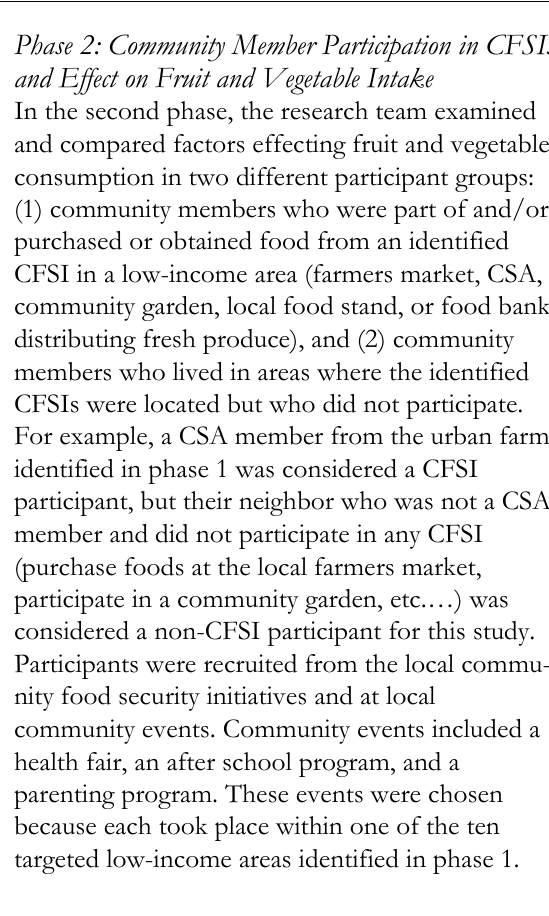
Table 1. The Type of Community Security Food Initiative Represented in the Key Informant